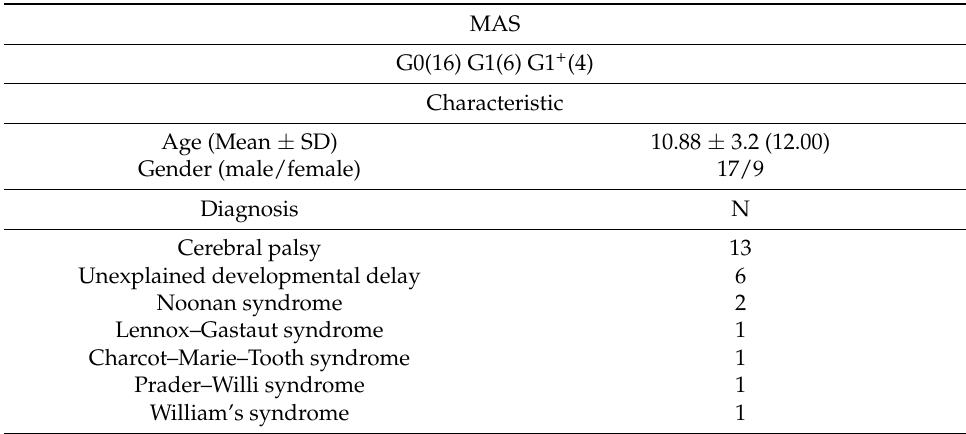
Table 1. General characteristics of participants (N = 26).